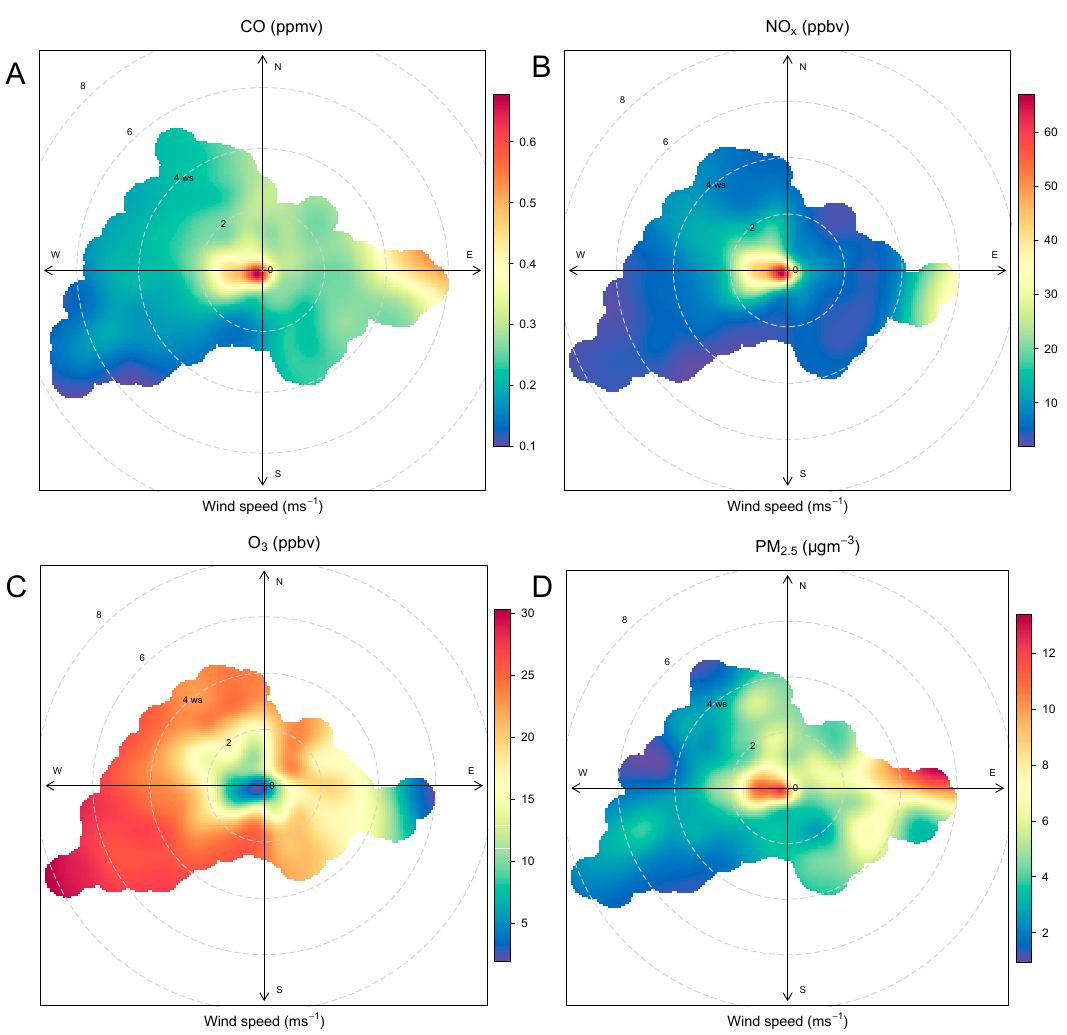
Figure 6. Polar bivariate plots of CO, NO x , O 3 and PM 2.5 (( A – D ), respectively) at the Auburn balcony location. Concentric circles from the origin indicate increasing wind speed, direction is indicated by quadrant and warmer colours indicate increasing pollutant concentration.